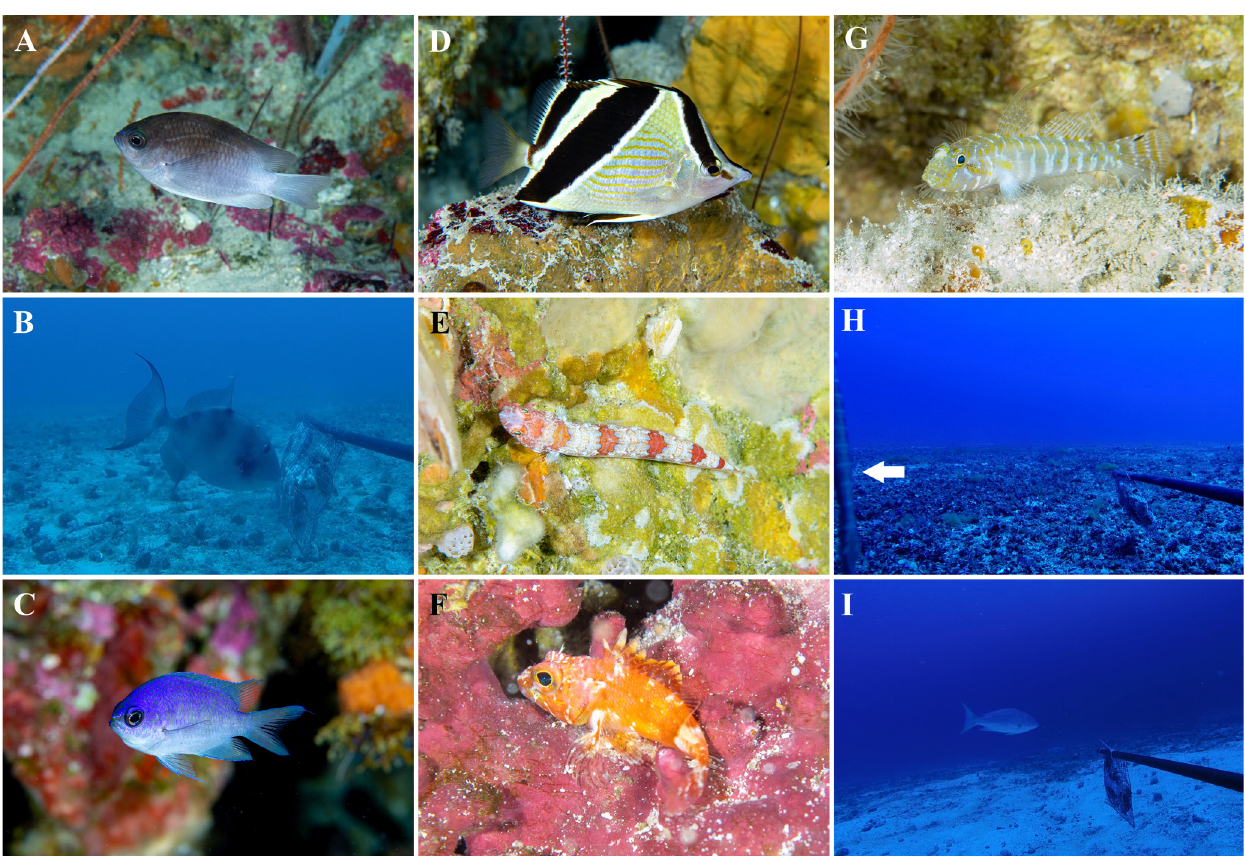
FIGURE 4 | New records of fishes at the mesophotic ecosystems. A. Chromis enchrysura (~ 10 cm total length); B. Balistes capriscus (~ 30 cm total length); C. Chromis scotti (~ 7.5 cm total length); D. Prognathodes guyanensis (~ 15 cm total length); E. Synodus sp. (~ 15 cm total length); F. Scorpaena sp. (~ 7.5 cm total length); G. Psilotris sp. (~ 5 cm total length); and H. Cosmocampus profundus (white arrow; ~ 15 cm total; I. Lutjanus buccanella (~ 50 cm total length). Photos by L. A. Rocha ( A , C - G ) and stereo-BRUVS ( B , H and I ). Tosanoides sp. is under description and its picture is not